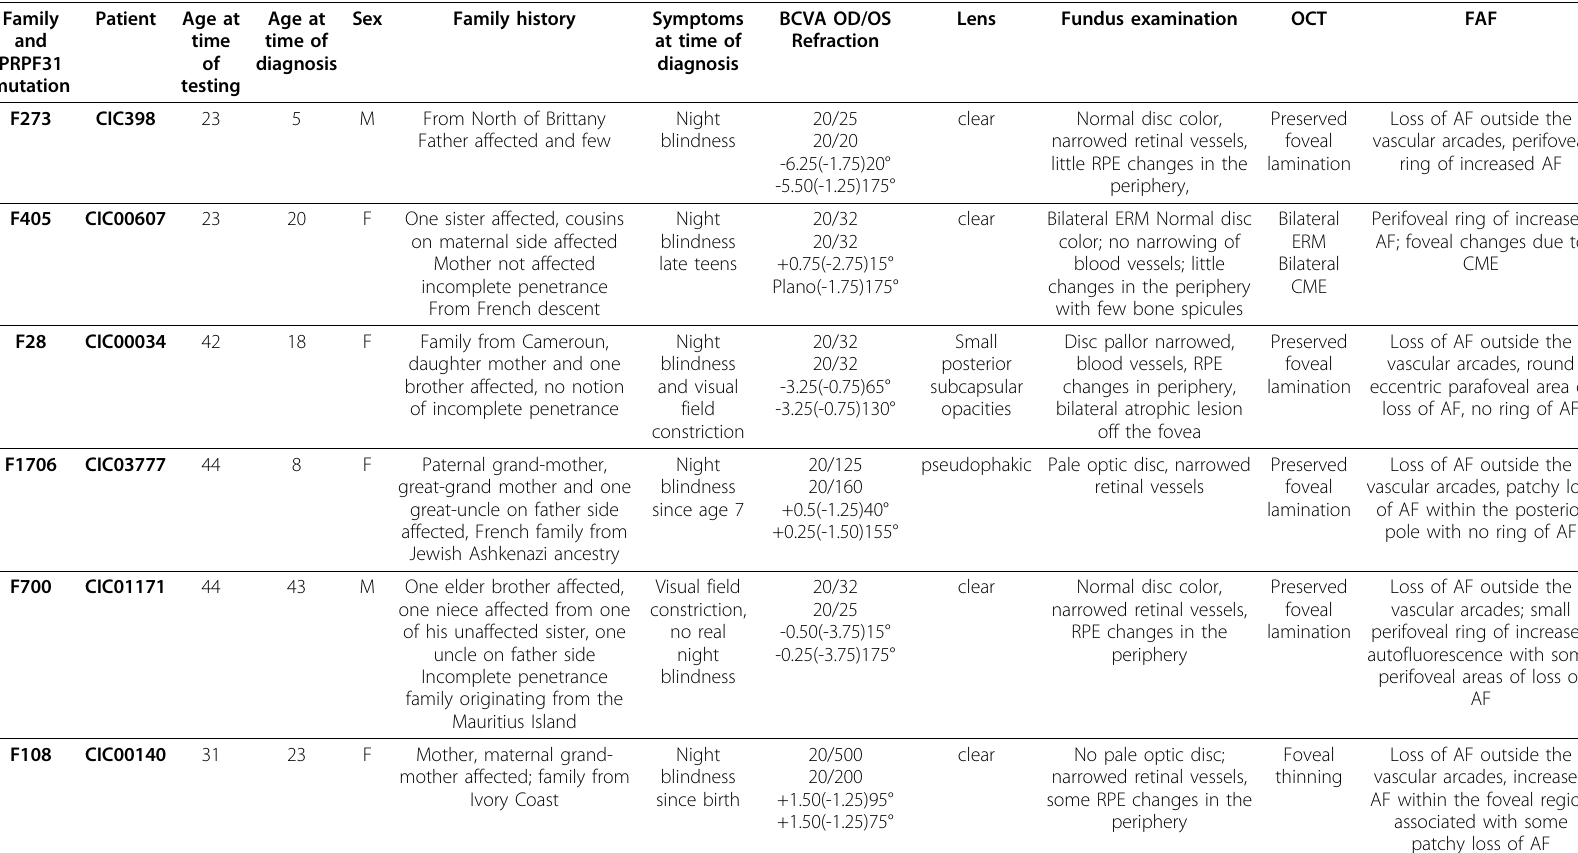
Table 3 Clinical data of affected members from families with adRP due to PRPF31 mutations Family and PRPF31